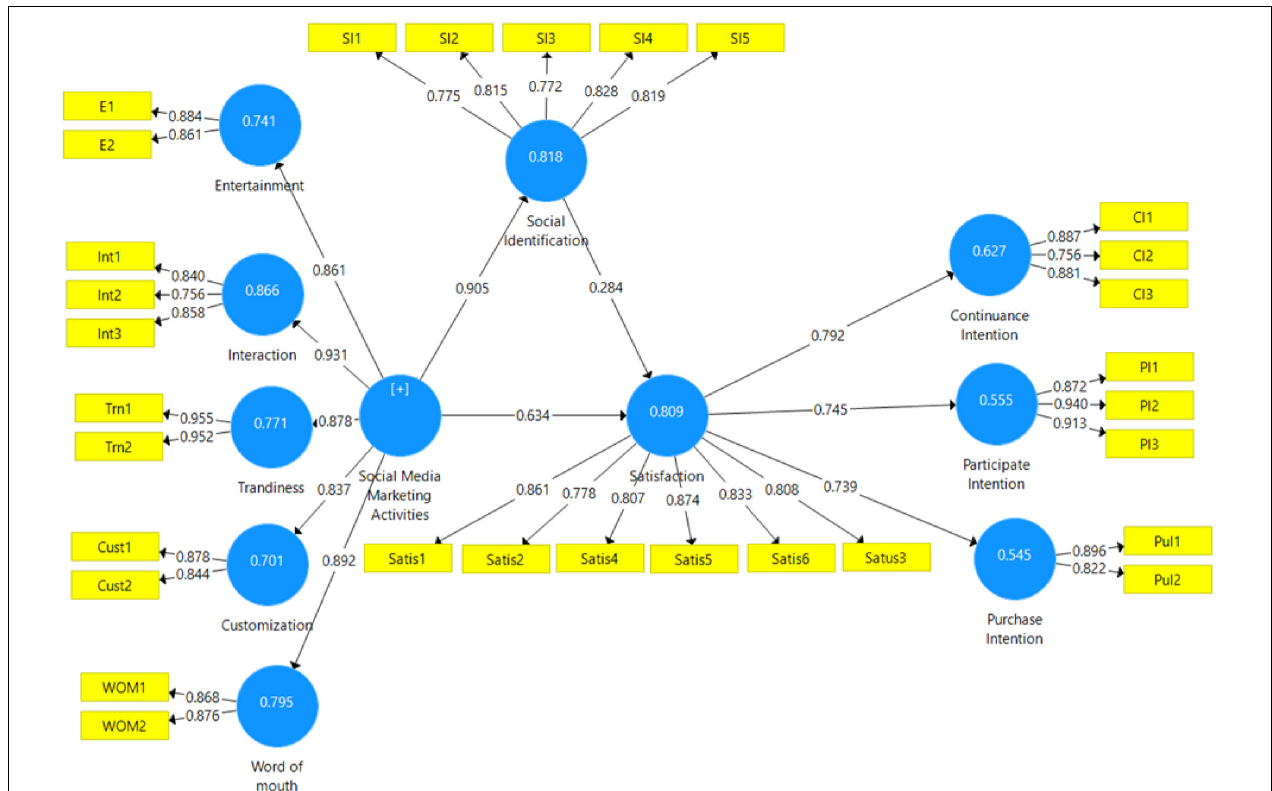
FIGURE 2 | Measurement model.